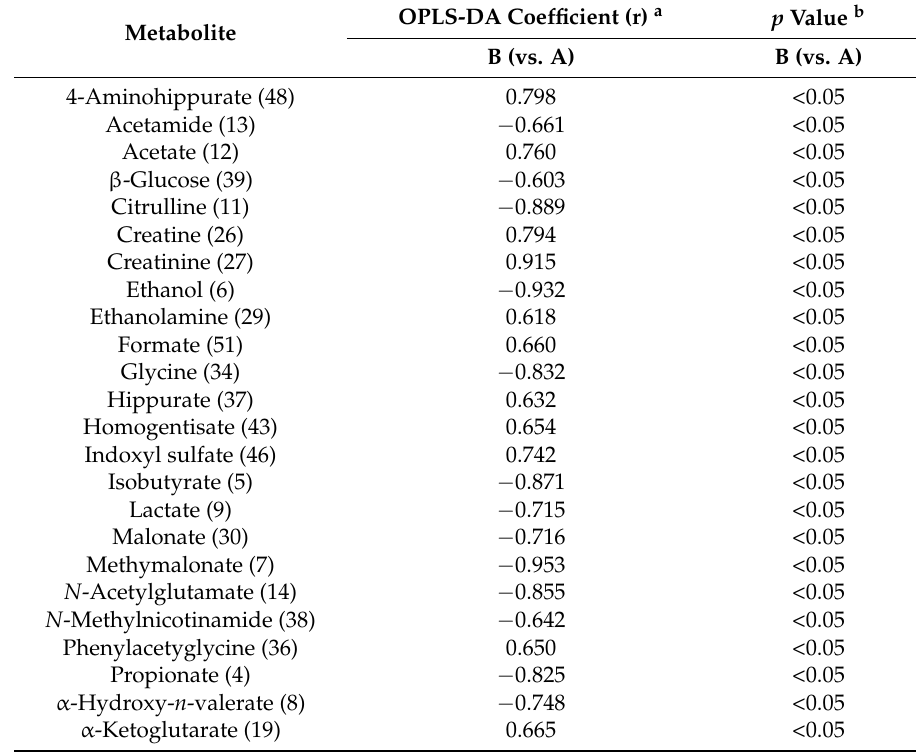
a Metabolite keys are shown in Table 2. Correlation coefficients were obtained from the OPLS-DA results, with the positive and negative signs suggesting the positive and negative correlation, respectively, with the concentrations. The correlation coefficient of |r| higher than 0.602 represents the cutoff value; b Normalized integral of metabolites in the spectrum (normalized to 100). Integrals of the altered metabolites were analyzed statistically using one-way analysis of variance (ANOVA) of SPSS 16.0 software (SPSS Inc., Chicago, IL, USA). p values are significant at the <0.05 level.